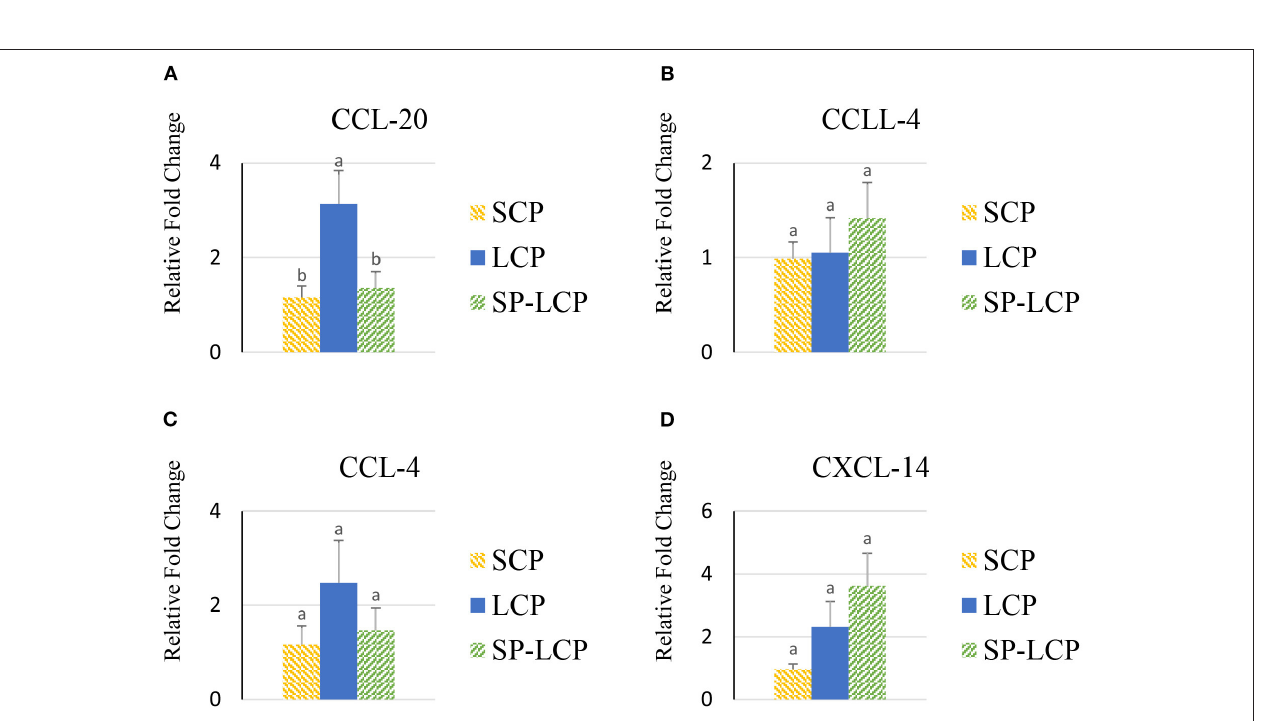
Frontiers in Veterinary Science |